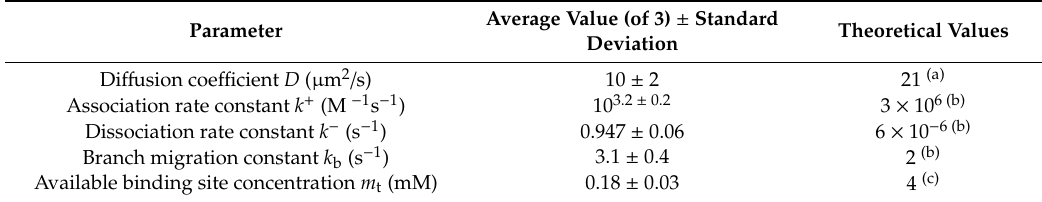
Table 2. Parameters obtained by fitting the reaction–diffusion model to the CLSM data for MO- T10 spatiotemporal distribution in MO hydrogels.